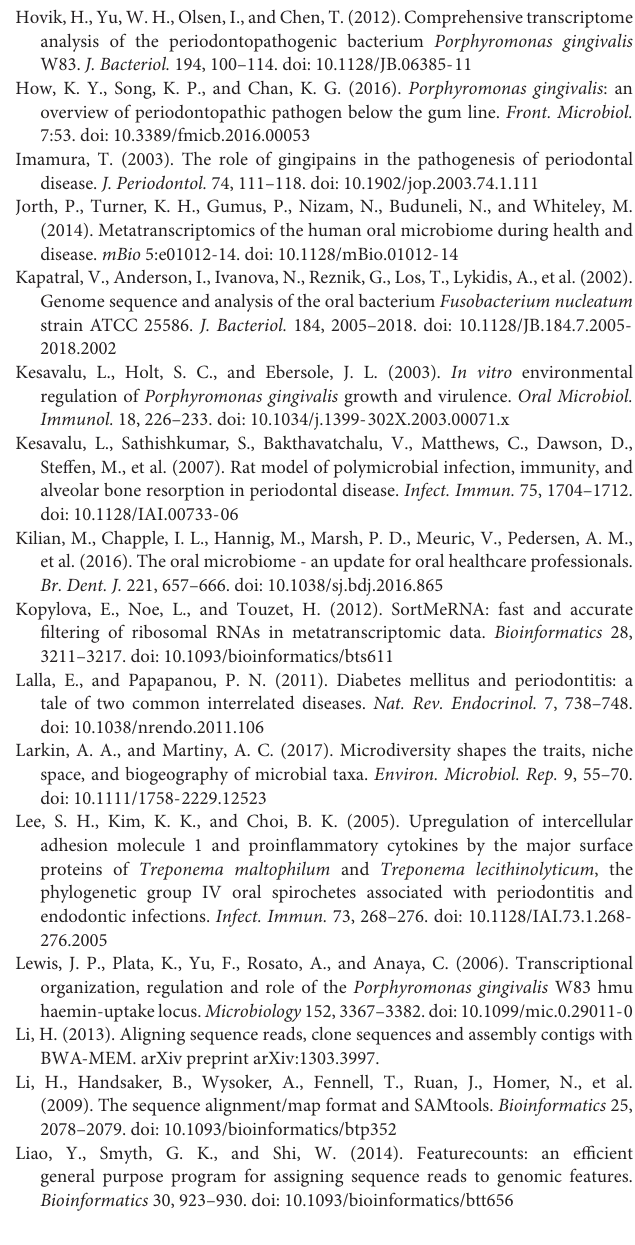
SHEET 15 | The number of variants detected in the transcriptomes of P. gingivalis , T. denticola , and F. nucleatum from periodontal niche and laboratory culture. SHEET 16 | The variants per gene in the transcriptome of P. gingivalis . SHEET 17 | The variants per gene in the transcriptome of T. denticola . SHEET 18 | The variants per gene in the transcriptome of F. nucleatum